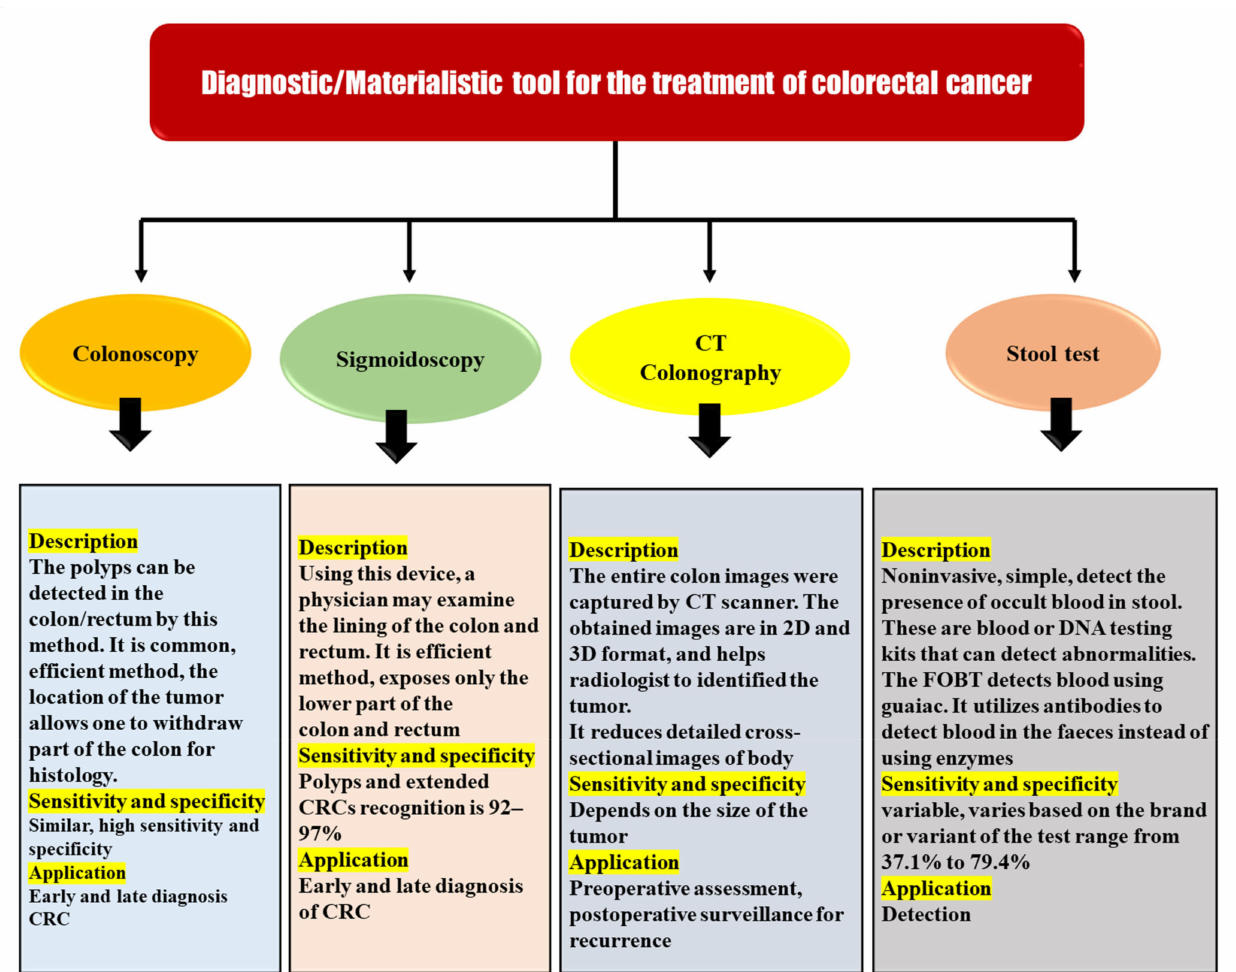
Figure 6. Diagnostic/materialistic tool for the treatment of colorectal